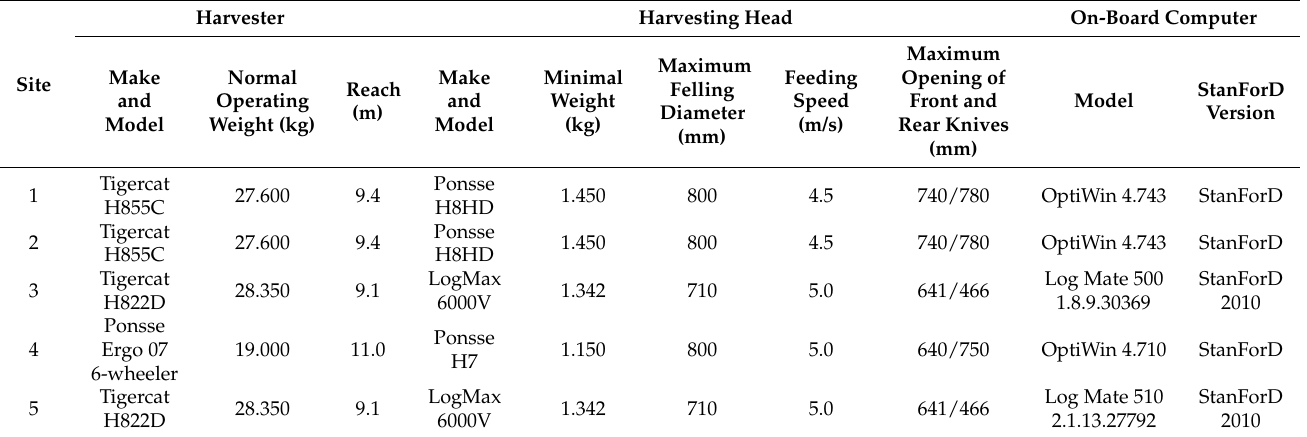
Table 2. Harvester, harvesting head, and on-board computer